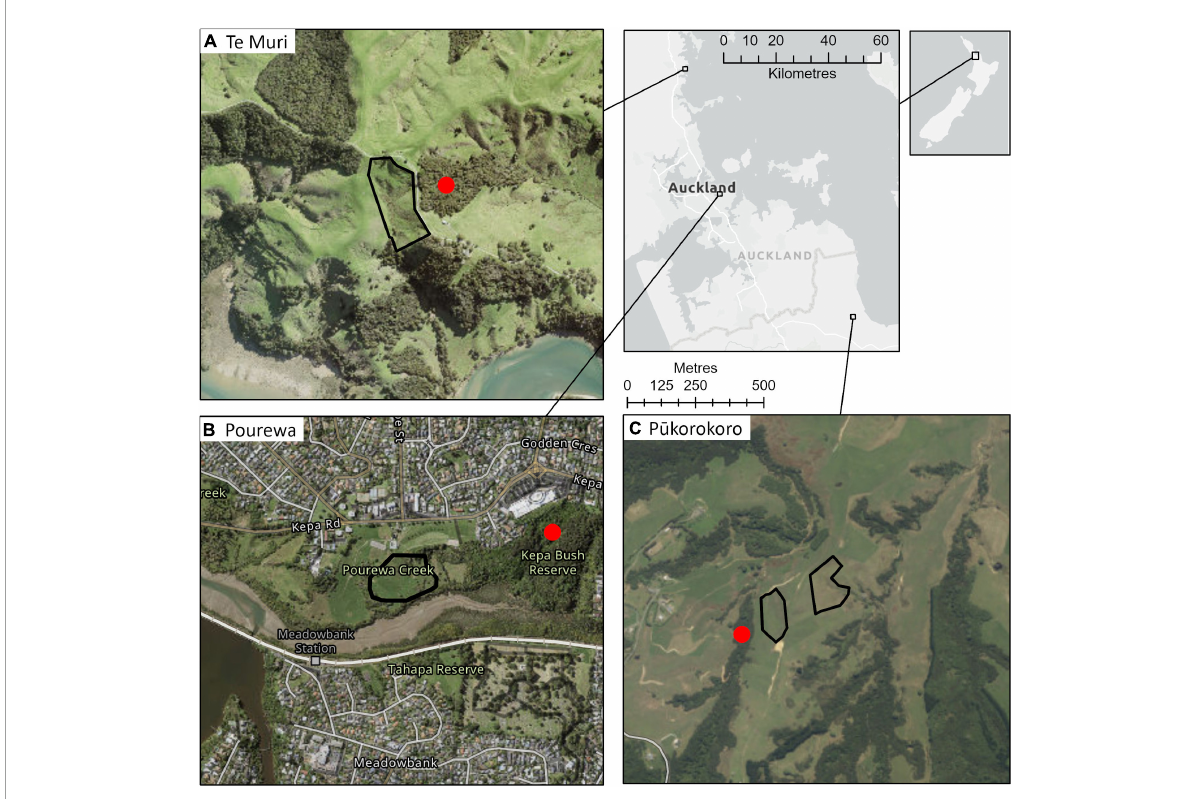
FIGURE1 AUT Living Laboratories program forest restoration experiment site locations within the context of the greater Auckland Region, and within Aotearoa New Zealand. The sites are: (A) Te Muri (3.8 ha), (B) Pourewa (2.1 ha), and (C) P ¯ ukorokoro (3.2 ha). The red dots indicate adjacent reference sites, which will be monitored for a subset of ecosystem functions ( Table 3 ) at a similar temporal frequency to the experimental sites to enable